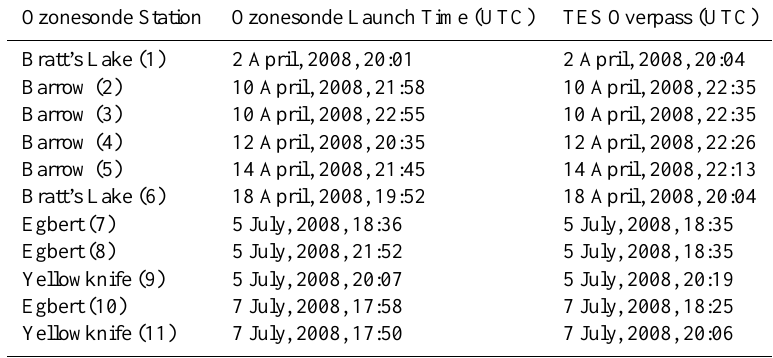
Table 1. Time overlap between ozonesonde launches and TES overpasses for the 11 TES Coincidences used for V003 and V004 TES data comparisons